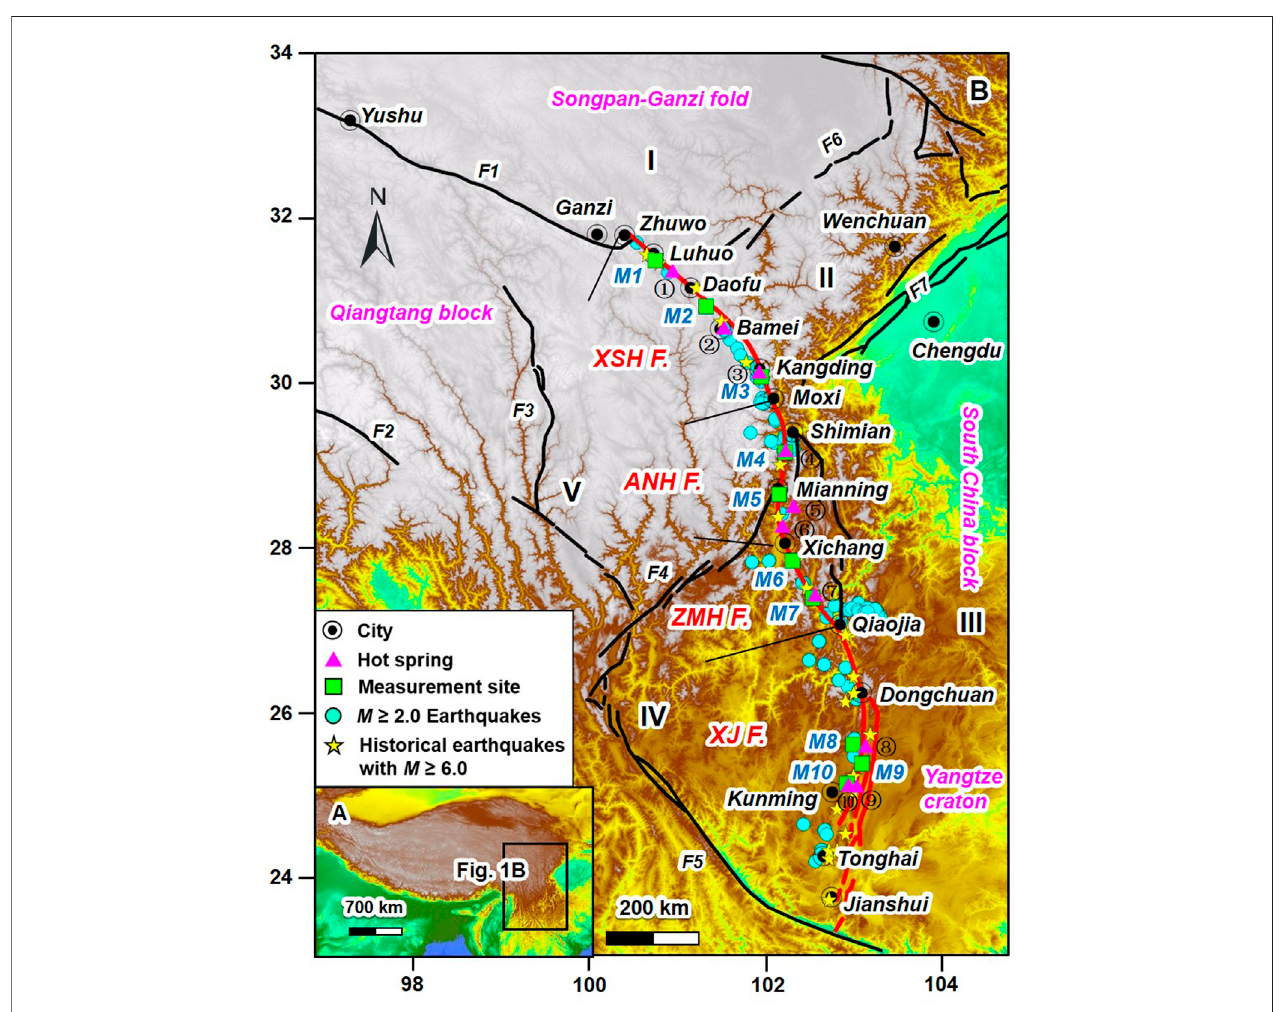
FIGURE 1 | (A) Geological map showing the location of the study area. (B) Tectonic and topographic map in the Chuan – Dian rhombic block. I, Ahba block; II, Longmenshan block; III, south China block; IV, the southern subblock of the Chuan – Dian terrace; V, the northern subblock of the Chuan – Dian terrane. F1, Ganzi-Yushu fault;F2,Jialifault;F3,Jinshajiangfault;F4,Xiaojinhefault;F5,RedRiverfault;F6,Longribafault;F7,Longmenshanfaultzone.Modi fi edafterJiangetal.(2014).M1-M10 are the soil-gas measurement sites in this study. Abbreviations of the faults: XSH, Xianshuihe fault; ANH, Anninghe fault; ZMH, Zemuhe fault; XJ, Xiaojiang fault. Numbers ① – ⑩ representthebubbling hotspringsdistributed alongthe XXFS(Kama,Guanding,Zimakua,Xide, Hongmo, Liutie, Xundiantang, Yiliang,and Tangchihot springs, respectively). The M ≥ 2.0 earthquakes occurred from January 2012 to October 2020 within 50 km of the XXFS. Earthquake data are from China Earthquake Networks Center (CENE, http://www.ceic.ac.cn). Data of the histotical earthquakes are from Wang et al. (2008) and Wen et al.